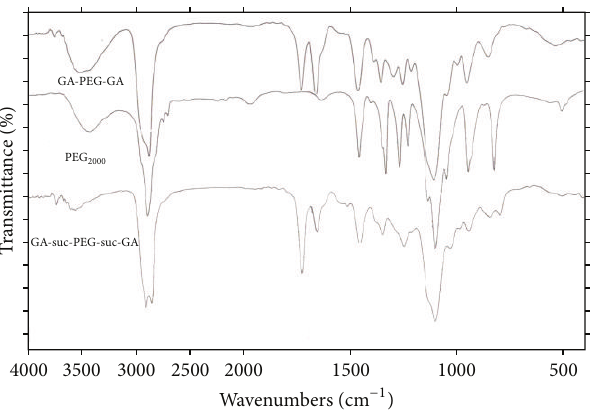
Figure 1: FT-IR spectra of PEG 2000 , GA-PEG-GA, and GA-suc-